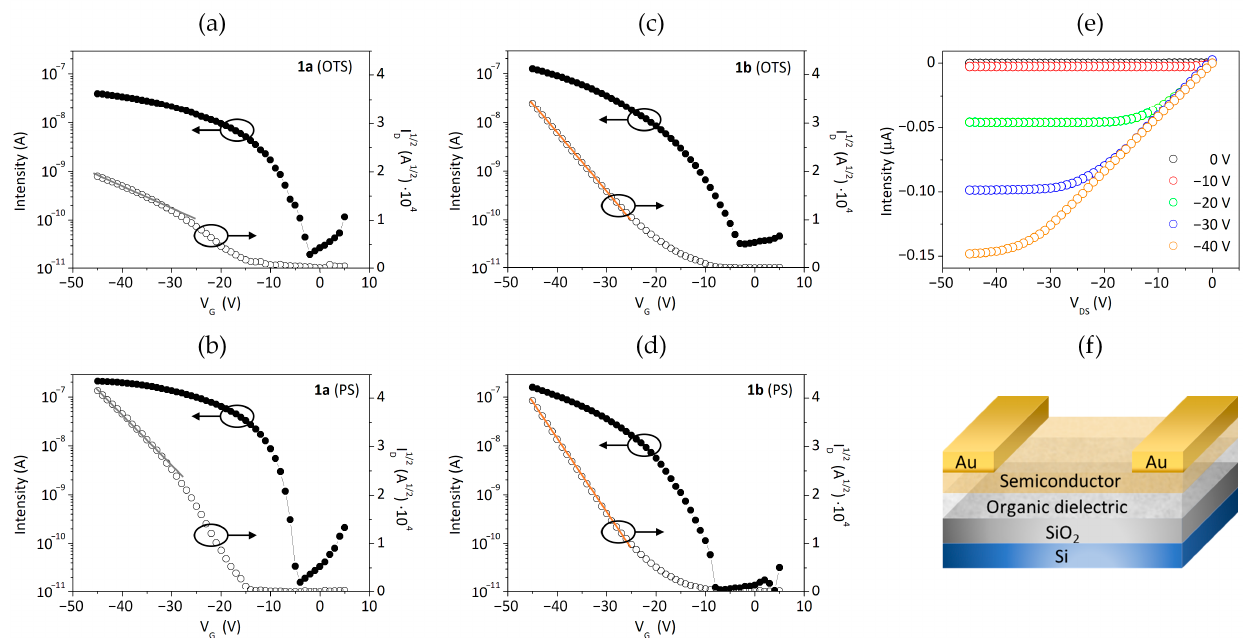
Figure 5. OTFT characteristics of representative devices fabricated with compounds 1a – b : transfer (V DS = − 40 V) and saturation characteristics with the linear adjustment employed to extract µ h of compound 1a in ( a ) OTS- and ( b ) PS-treated devices; of compound 1b in ( c ) OTS- and ( d ) PS-treated devices; ( e ) output characteristics of a PS-treated device fabricated with compound 1a ; ( f ) scheme of the studied bottom gate-top contact OTFTs.